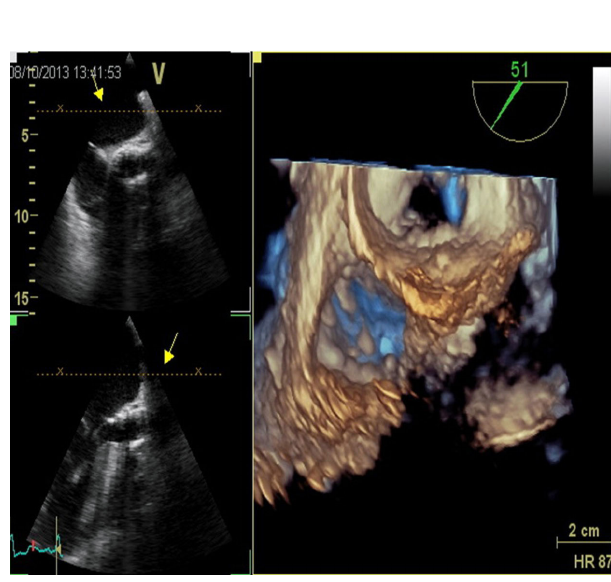
Fig. 2 – Intraoperative 3D Transesophageal